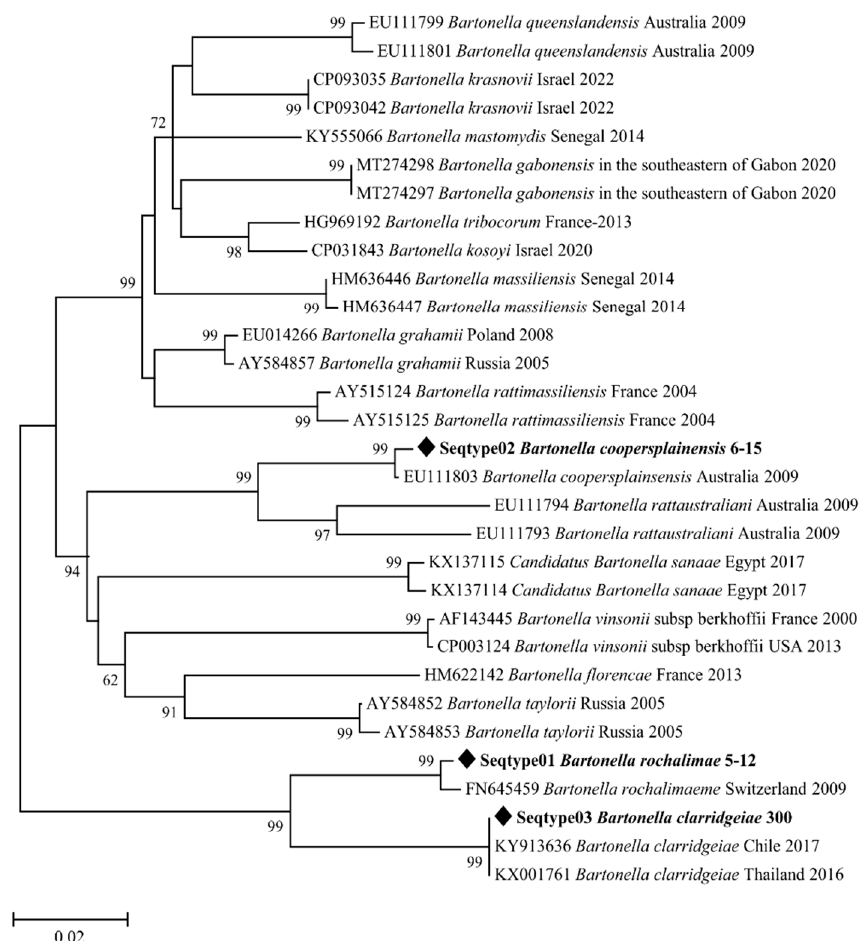
Figure 4. Neighbour-joining (NJ; 500 bootstrap replicates) phylogenetic tree of the gltA gene. Bar- Figure 4 . Neighbour ‐ joining (NJ; 500 bootstrap replicates) phylogenetic tree of the gltA gene. tonella spp. sequences ( (cid:117) ) obtained in this Bartonella spp. sequences ( ) obtained in this study.